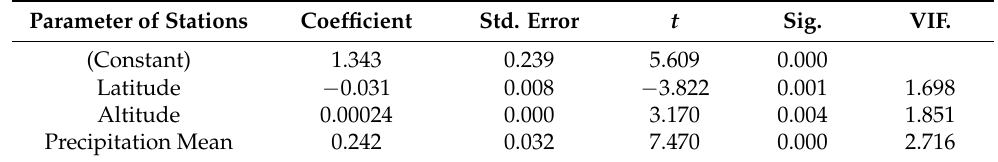
Table 4. Results of a linear regression of the prediction accuracy of IMERG data based on station parameters.